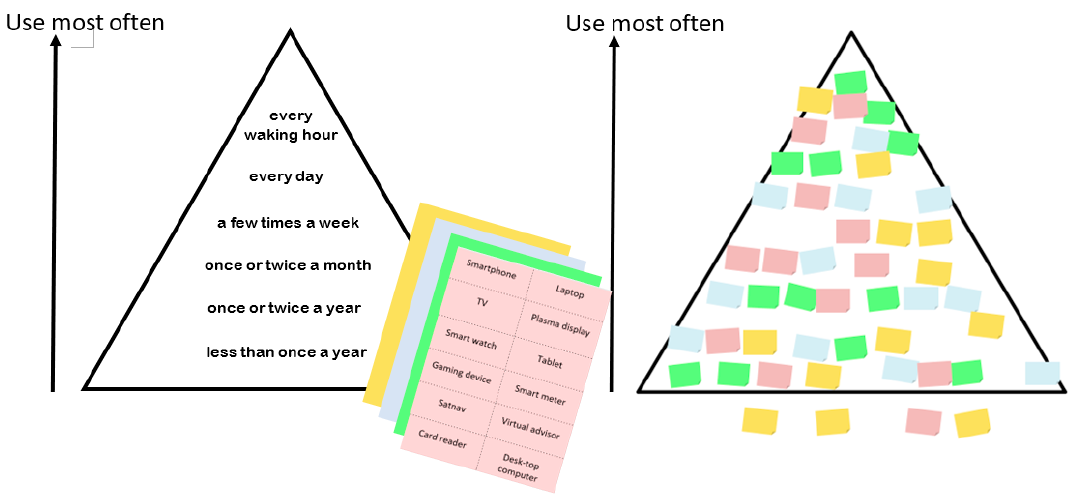
Figure 3. Schematic to show the configuration of Activity 3.